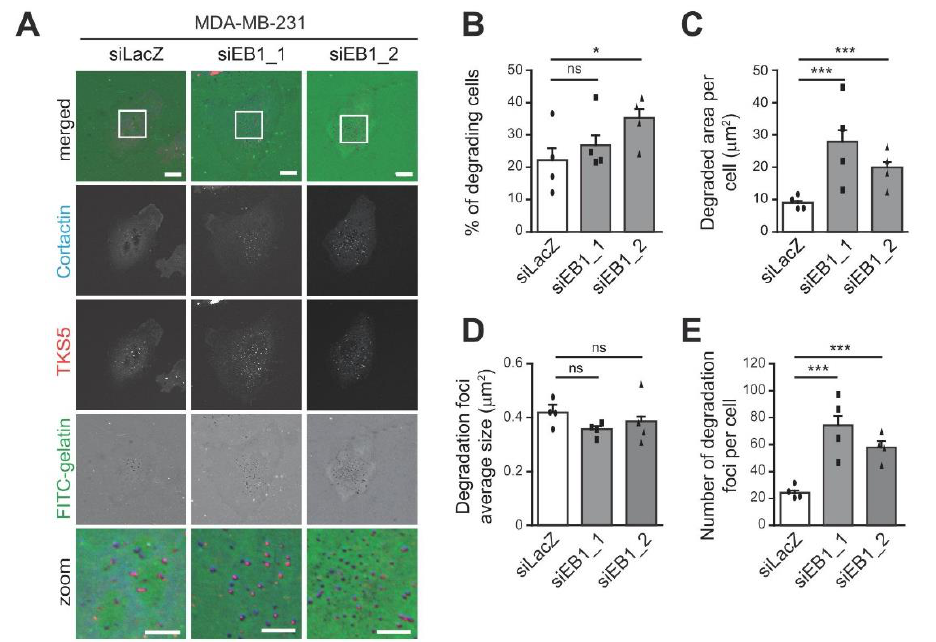
Figure 1. End Binding protein (EB1) restricts extracellular matrix (ECM) degradation via inhibition of invadopodia formation in MDA-MB-231 breast cancer cells. MDA-MB-231 cells were transfected with a control siRNA (siLacZ) or siRNAs against EB1 (siEB1_1 or siEB1_2) and seeded on fluorescently-labeled gelatin (FITC-gelatin) for 4 h. Cells were fixed and stained with antibodies directed against Cortactin and TKS5 to identify invadopodia. Matrix degradation was identified thanks to the appearance of dark spots in FITC-gelatin. ( A ) Representative images are shown. The white-boxed regions are enlarged at the bottom (zoom). Scale bars represent 10 µ m in non-enlarged images, 5 µ m in enlarged images. ( B – E ) The ability of MDA-MB-231 cells to degrade fluorescently-labeled gelatin was analyzed. The percentage of degrading cells ( B ), the degraded area per cell ( C ), the average size of degradation foci ( D ), and the number of degradation foci ( E ) are represented as the mean ± SEM of four independent experiments. The mean of each individual experiment is reported. Percentage of cells degrading was assessed by imaging 10 random fields per coverslip, 2 coverslips per condition per experiment. The unpaired one-tailed t -test, with Welch correction, was used to determine significant differences. Matrix degradation was analyzed by quantifying the mean degraded area and the number of degradation foci per cell using home-made Fiji macro, analyzing 25 cells per condition per experiment. The Mann–Whitney test was used to determine significant differences. *** p ≤ 0.001, * p ≤ 0.05, ns not